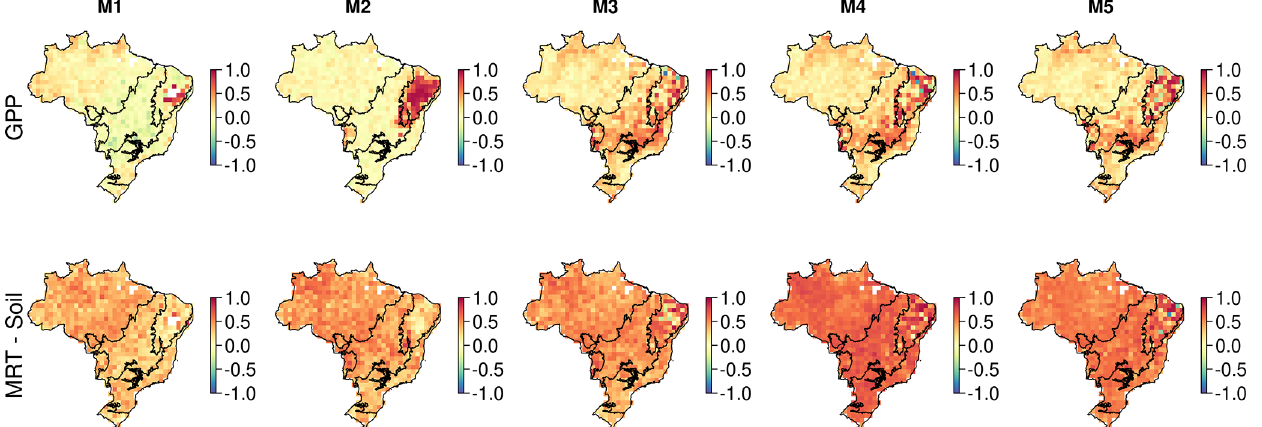
Figure 9. Correlation maps between the simulated change in DOM stocks (SSP2-4.5; 2001–2100) and ecosystem variables. These maps identify the spatial variation in the sensitivity of biomass change to key ecosystem variables. Correlates are soil MRT (years) and GPP (gCm − 2 d − 1 ) estimated across the whole simulation